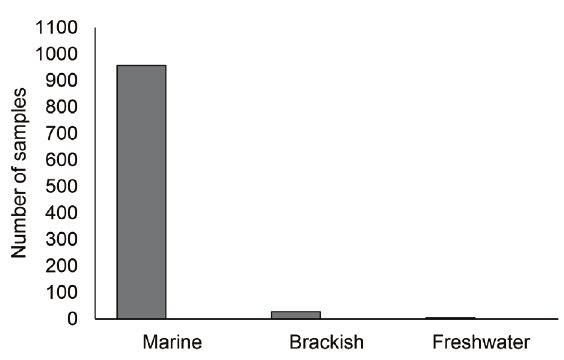
Figure 2. Number of samples on host teleost according to environment of